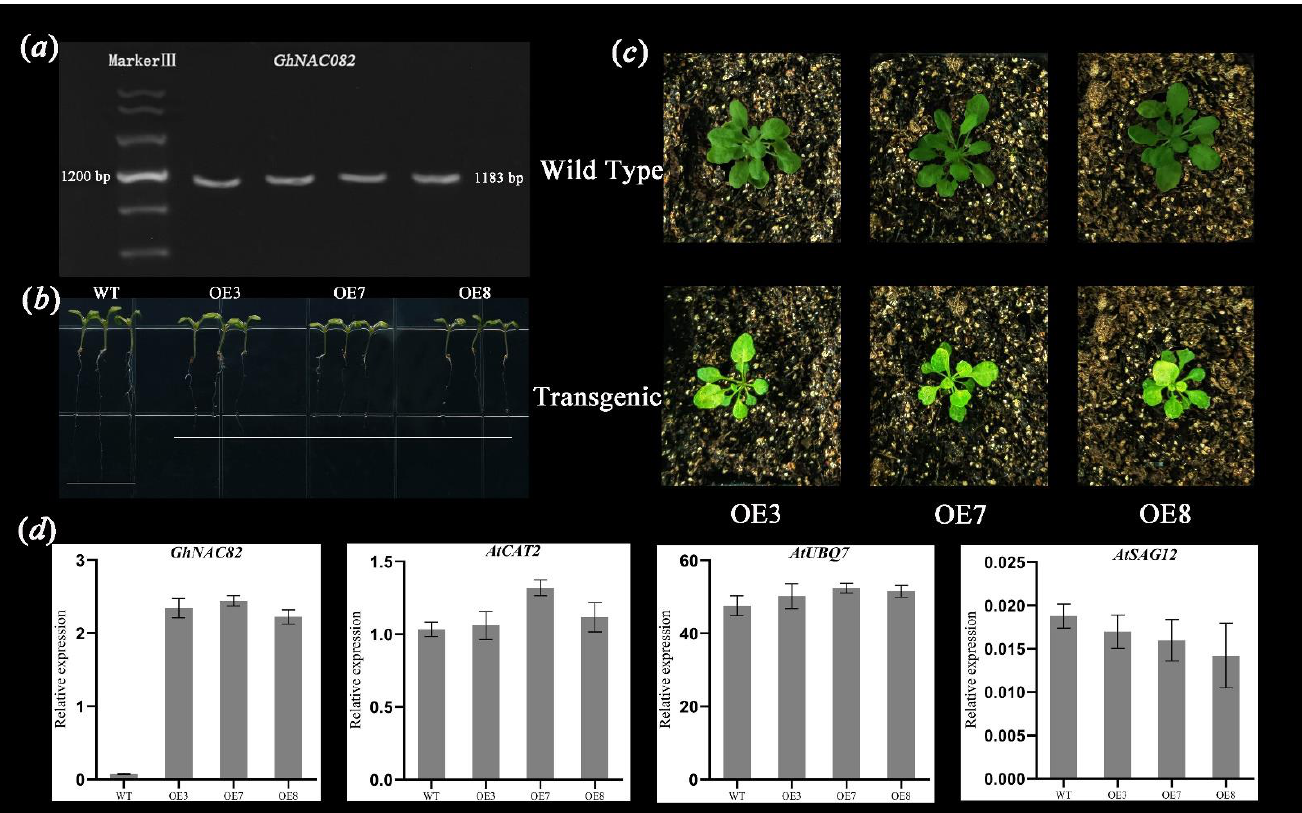
Figure 7. Overexpression of GhNAC82 leads to premature senescence of Arabidopsis plants. ( a ) Agarose gel electrophoresis detection; ( b ) Comparison of root systems between wild-type and overexpression plants; ( c ) Comparison of leaf senescence degree between wild-type and overexpression plants; ( d ) Expression levels of GhNAC82 , AtCAT2 , AtUBQ7 , and AtSAG12 in wild-type and overexpression plants.